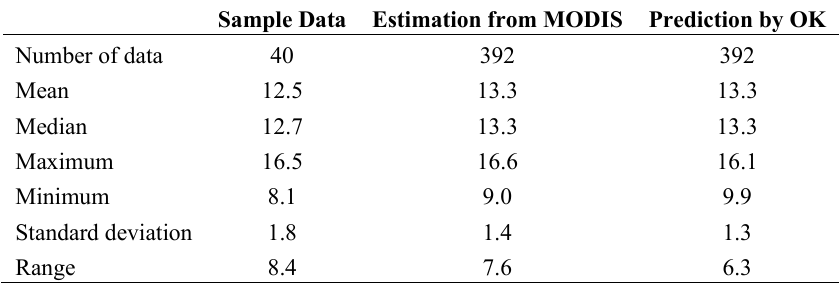
Table 2. Descriptive statistics of three datasets of Chl-a concentrations (mg/m 3 ): water samples, estimations from the MODIS image data by rGBr and predictions at the MODIS pixels by cross-validation of ordinary kriging (OK).